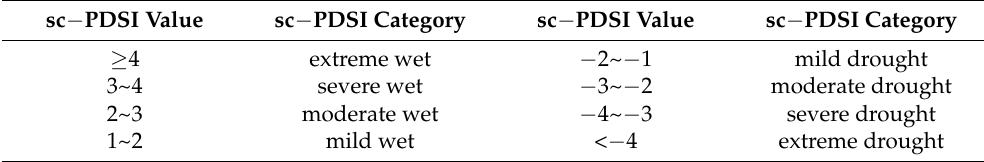
Table 1. Classification of sc-PDSI values.